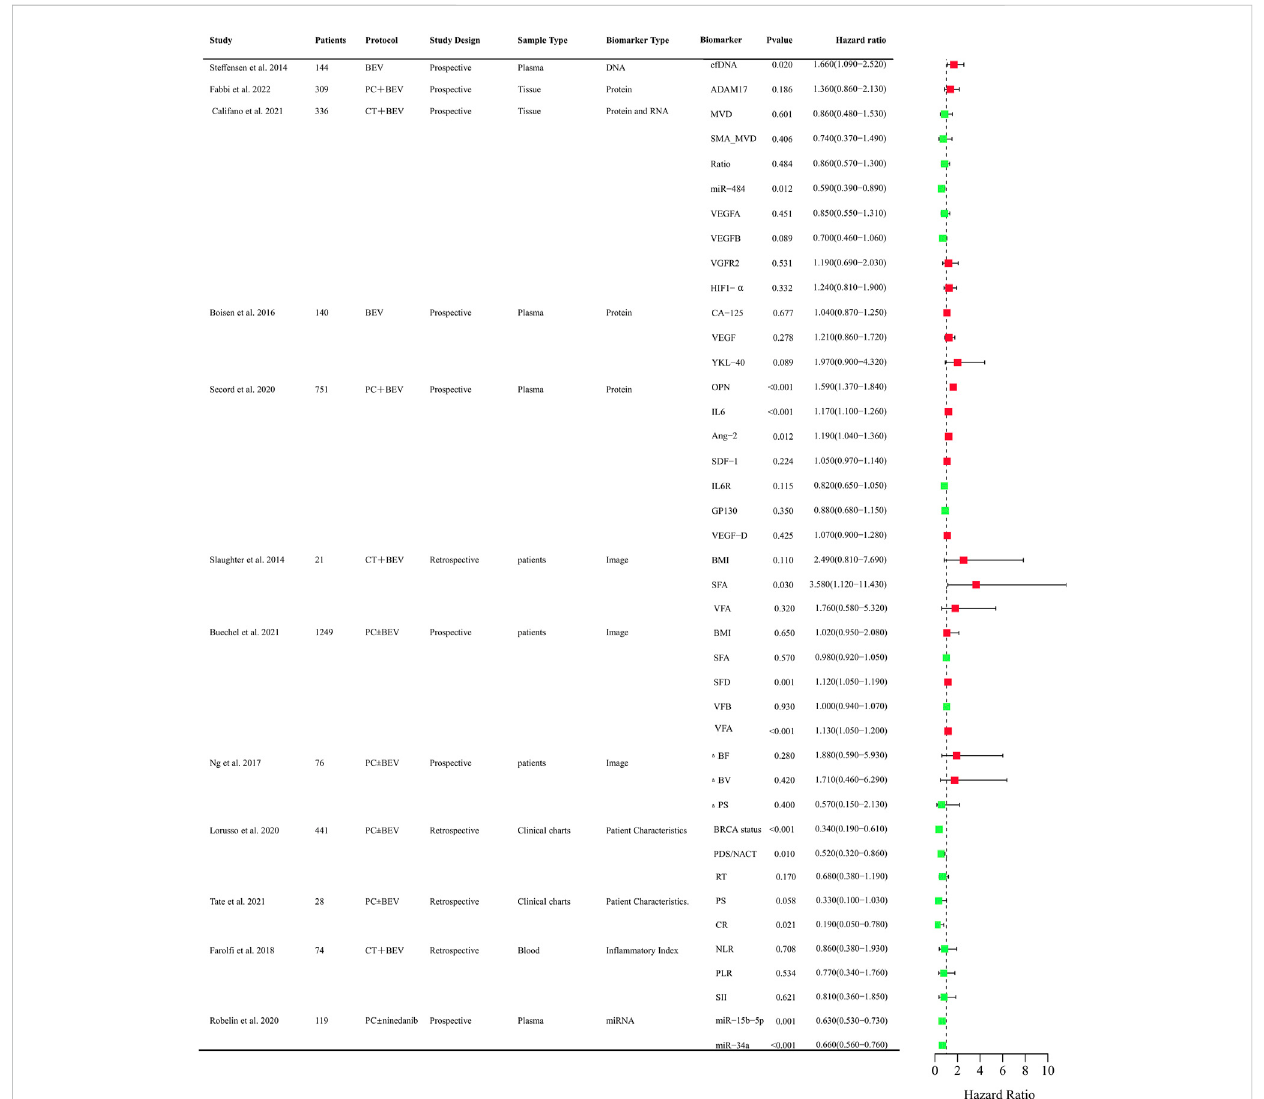
FIGURE 3 Clinical trials assessing biomarkers in relation to OS of anti-angiogenic drugs in OC. BEV: Bevacizumab; CT: Chemotherapy; PC:TAXOL and CBP; DNA, Deoxyribonucleic Acid; RNA, Ribonucleic Acid; cfDNA, cell-free DNA; ADAM17, a disintegrin and metalloprotease 17; MVD, microvessel density; SMA_MVD: Alfa-Smooth Muscle Actin + microvessel density; Ratio, α -SMA + MVD/MVD ratio; miRNA, microRNA; VEGFA, vascular endothelial growth factor A; VEGFB, vascular endothelial growth factor B; HIF-a, Hypoxia-Inducible Factor 1-alpha; OPN, osteopontin; SDF-1, stromal cell – derived factor-1;IL6R,IL6receptor;FLT4,fms-liketyrosinekinase-4;AGP,a1-acidglycoprotein;BMI,bodymassindex;VFA,visceralfatarea;SFA,subcutaneous fat area; Δ BF, change of Tumor Blood Flow; Δ BV, change of Tumor Blood Volume; Δ PS, change of Vessel Permeability Surface Product; PDS/NACT, Primary Debulking Surgery/Neoadjuvant chemotherapy; RT, Residual Tumor; PS, Performance Status; CR, Completeness of resection; NLR, neutrophil- to-lymphocyte ratio; PLR, platelet-to-lymphocyte ratio; SII, systemic immune in fl ammation index; SFD, subcutaneous fat density; VFD, visceral fat